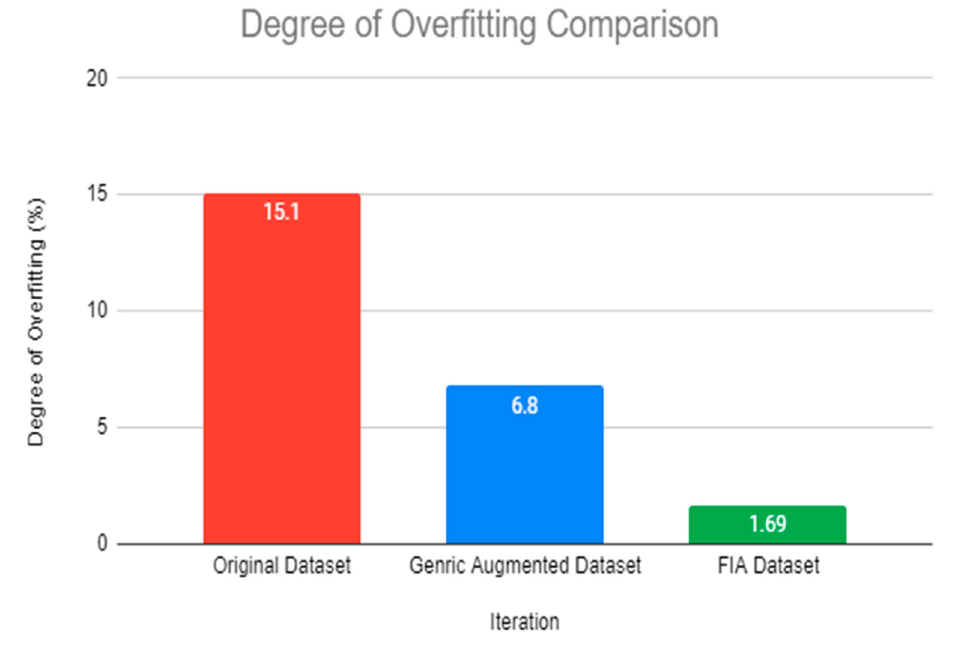
Figure 12. Degree of overfitting comparison.